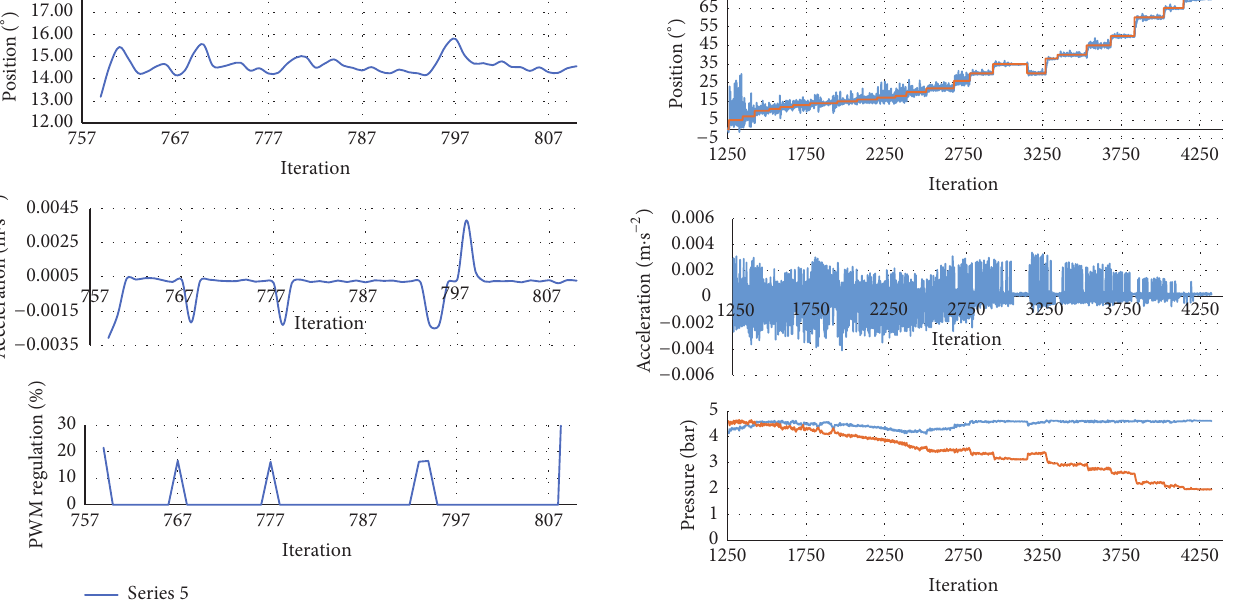
Figure 11: Analysis of the graphs of the series number 5 of the experimental measurement number 1.